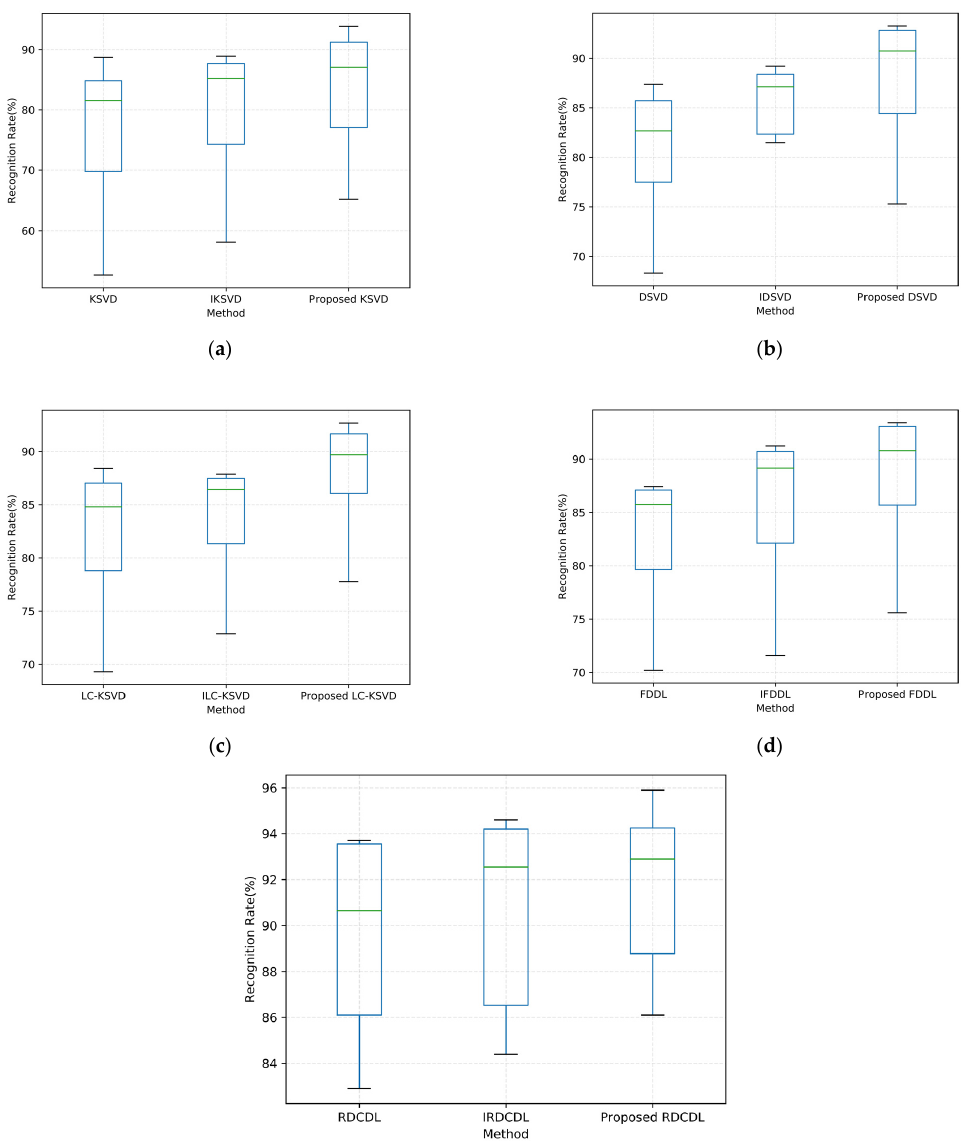
Figure 6. ( a ) Comparison of different KSVD algorithms; ( b ) Comparison of different DSVD algorithms. ( c ) Comparison of different LC-KSVD algorithms; ( d ) Comparison of different FDDL algorithms; ( e ) Comparison of different RDCDL algorithms. The accuracy of image classification increases steadily with the increase of atomic number. Compared with other algorithms, the proposed algorithm generally has advantages.